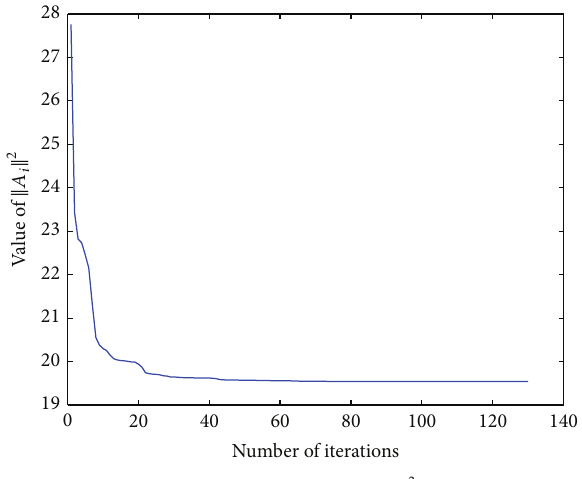
Figure 1: Trajectory of ‖𝐴 𝑖 ‖ 2 . Figure 2: Average performance trajectory of norm-reducing tech-